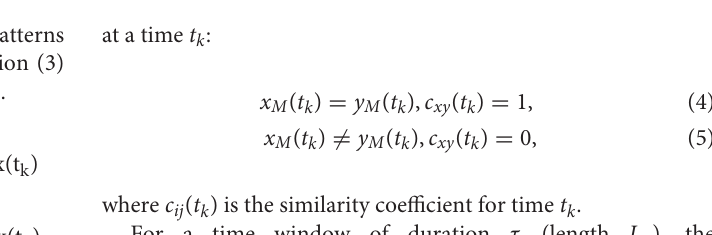
x ( t k ) > x ( t k + 1 ) > x ( t k + 2 ) (in fact, the number of possible patterns is n !). Given labels, these patterns become motifs. Equation (3) represents the six motifs for n = 3 , also shown in Figure 2